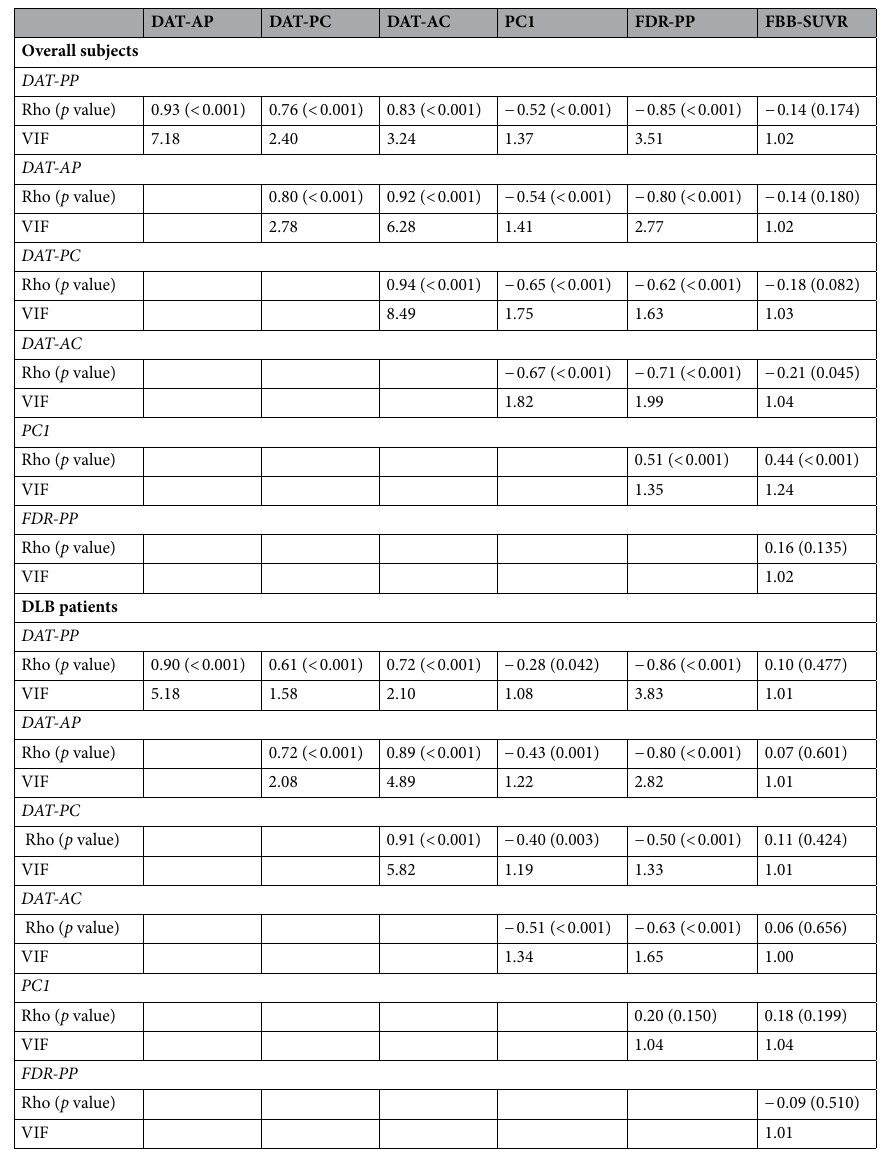
Table 2. Correlation between imaging biomarkers in overall subjects and DLB patients. Rho and p values are results of Pearson’s correlation analyses. DAT dopamine transporter, DAT-AP DAT uptake in the anterior putamen, DAT-AC DAT uptake in the anterior caudate, DAT-PC DAT uptake in the posterior caudate, DAT-PP DAT uptake in the posterior putamen, FBB-SUVR 18 F-Florbetaben standardized uptake value ratio, FDG 18 F-fluorodeoxyglucose uptake, FDR-PP FDG to DAT ratio in the posterior putamen, PC1 the first principal component of FDG subject residual profile, VIF variance inflation